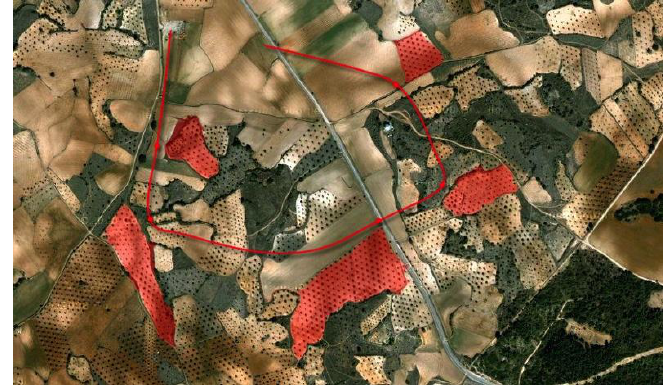
Figure 2. Several crop parcels where a desired aerial trajectory is